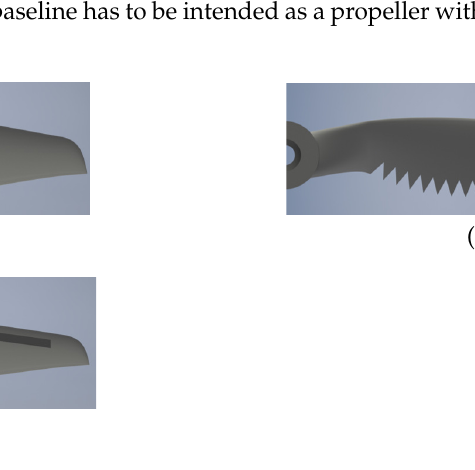
Figure 3. 3D rendering of the propeller blade: ( a ) baseline; ( b ) serrated trailing edge; ( c ) boundary layer tripping